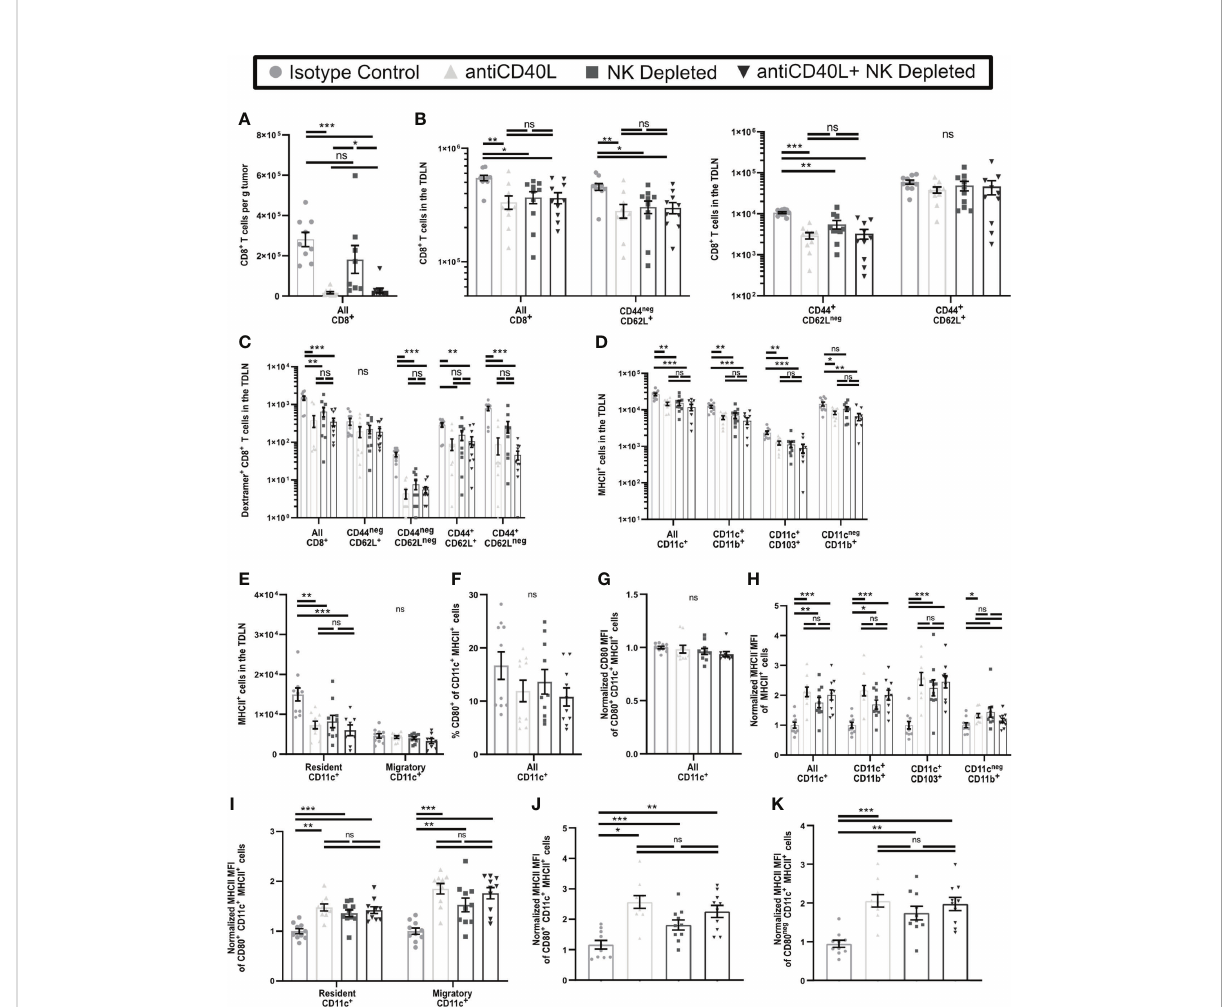
FIGURE 7 Blockade of CD40L and NK Depletion result in similar T cell and APC phenotypes in the TDLN. B16-ova tumors were implanted into WT B6 mice treated with isotype control or anti-NK1.1 depleting antibodies on D-2, D1, and D4, or isotype control or anti-CD40L blocking antibody starting on the day of tumor implantation and then on D2, D4, and D6, or a combination of NK cell depletion and anti-CD40L blockade. Tumor (A) or TDLN (B – K) were harvested at D7. Single cell suspensions of tumor samples were enriched for CD45 + cells by MACS Beads and analyzed by fl ow cytometry. Single cell LN samples were analyzed by fl ow cytometry. (H – K) For each APC subset, the indicated MFI was normalized to the isotype control average of that same subset separately for each experiment. (J, K) The MHCII MFI was normalized to the isotype